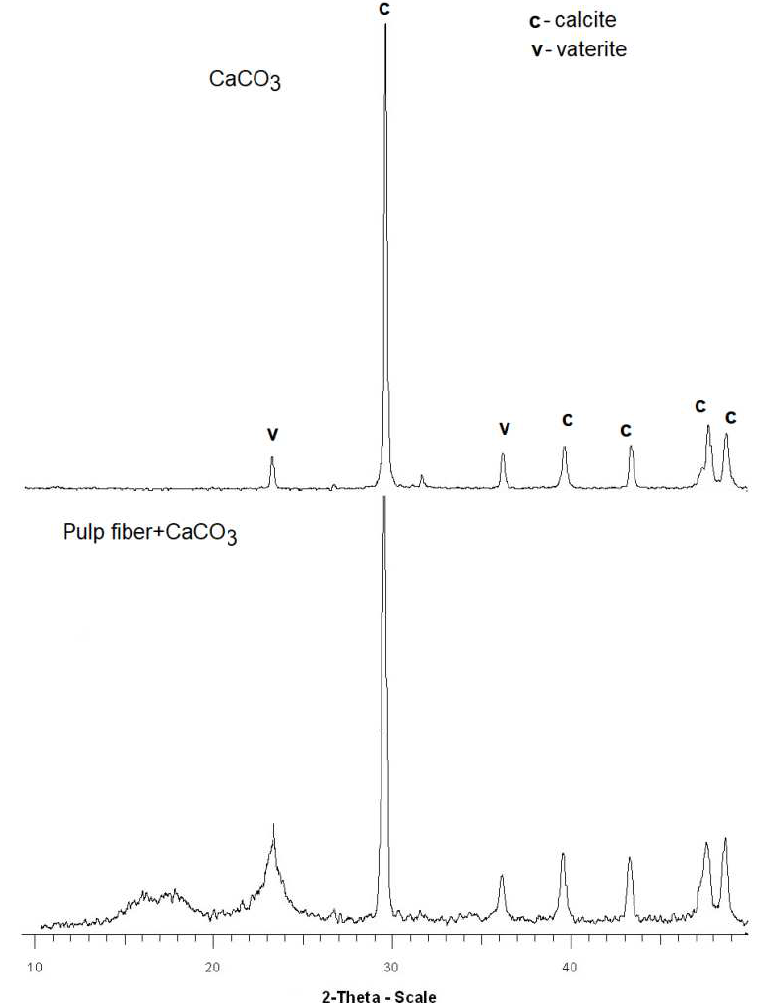
Figure 2. X-ray diffraction spectrum for PCC and paper loaded with PCC.